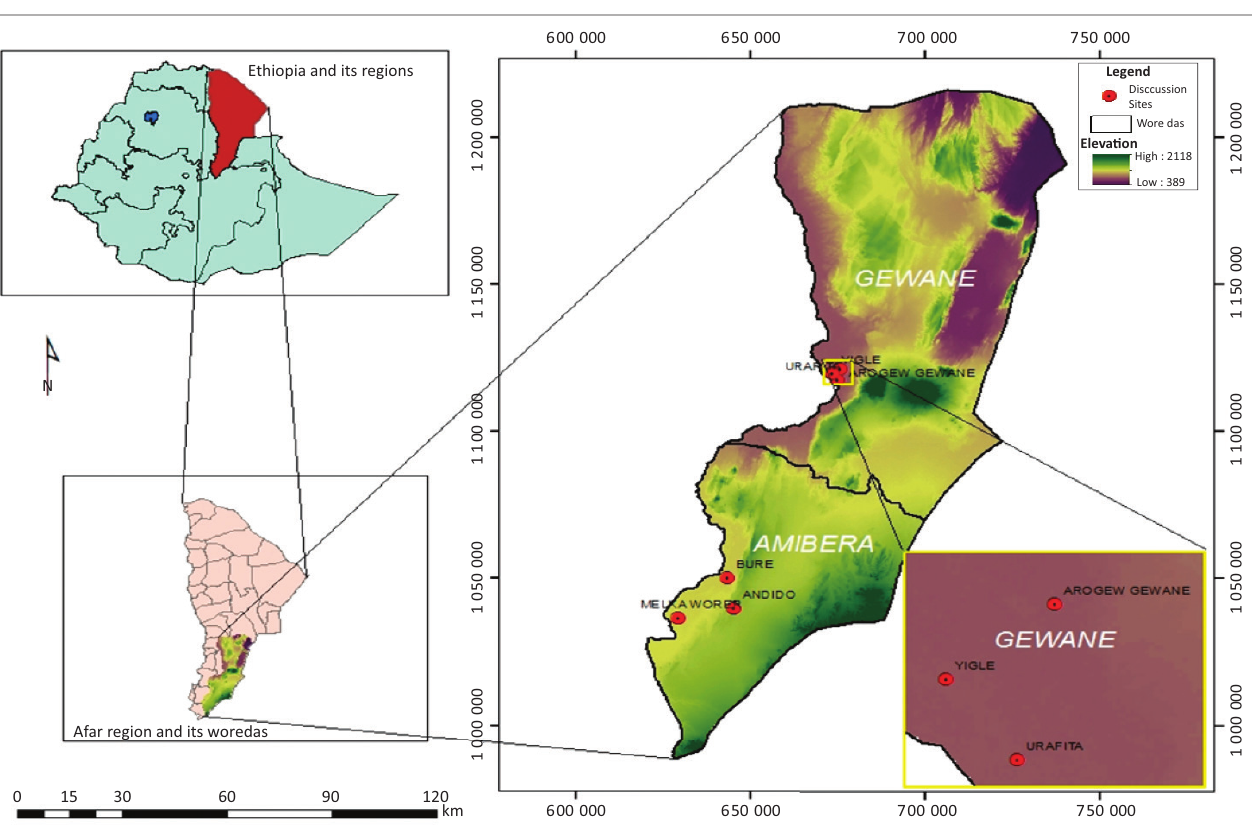
FIGURE 1: Map of the study